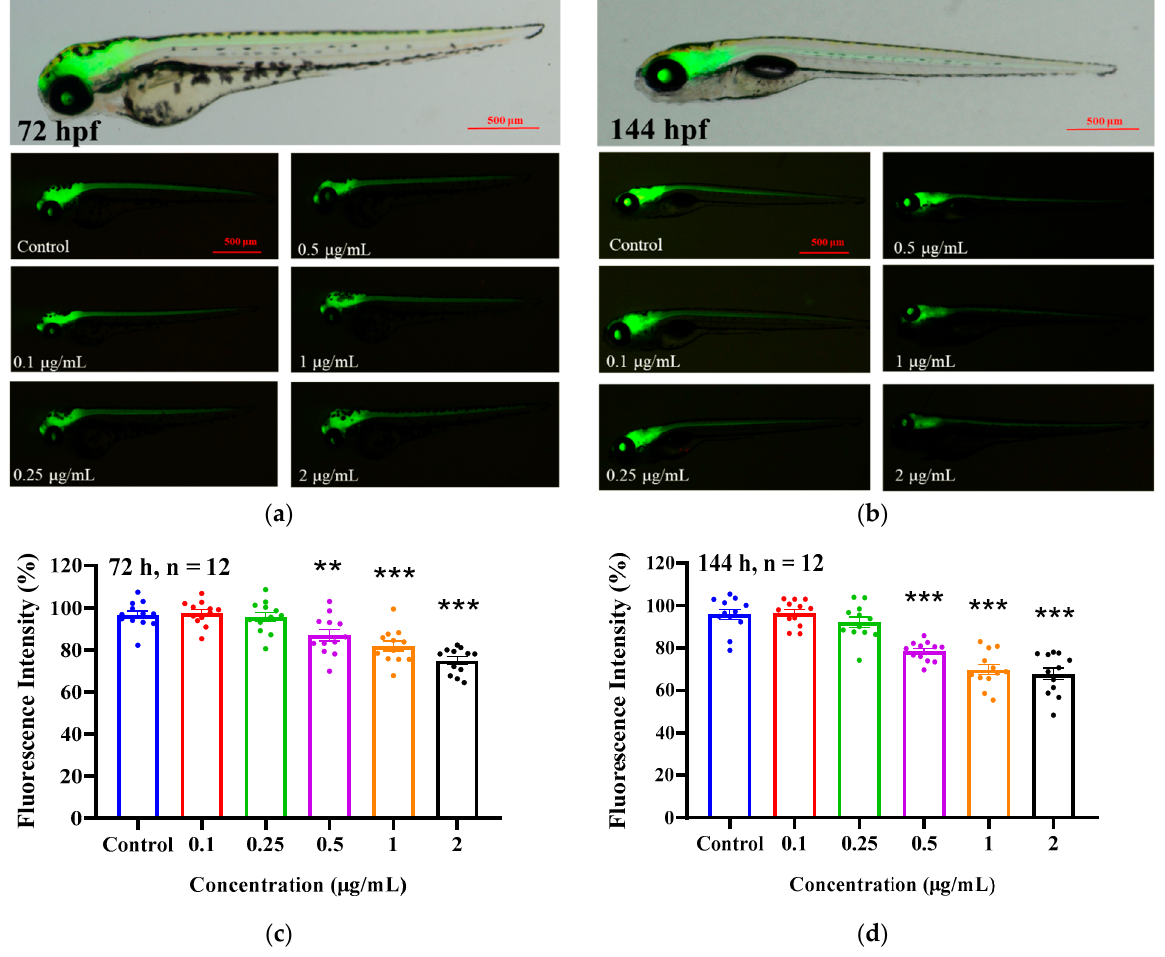
Figure 3. EMB exposure suppressed the expression of central nervous fluorescence in Tg (HuC-GFP) zebrafish. Green fluorescence images ( a , b ) and fluorescence statistics ( c , d ) of central nervous system (CNS) neurogenesis in Tg (HuC-GFP) zebrafish at 72 and 144 hpf ( n = 12 in each group). ** p < 0.01, *** p < 0.001, compared to the control group.